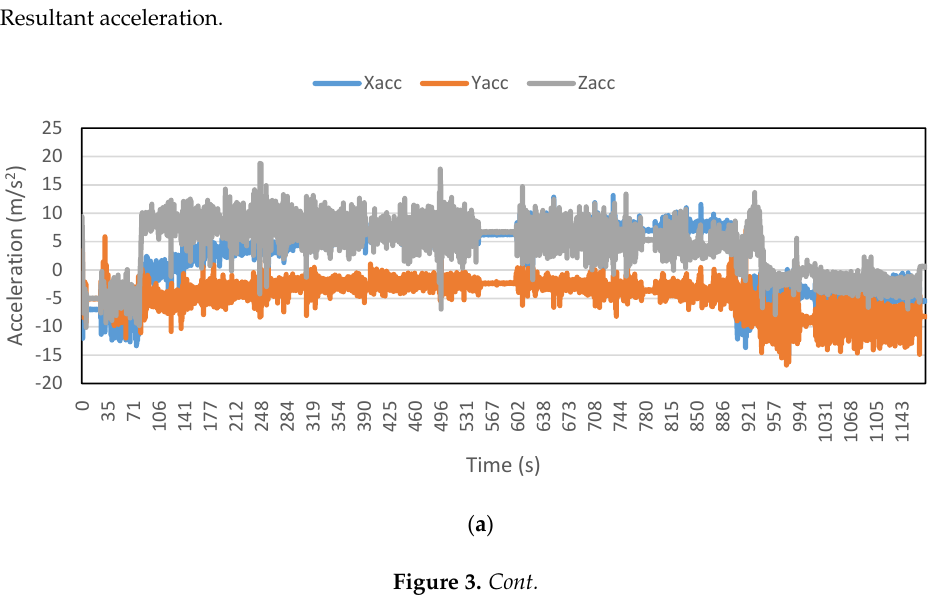
Figure 2. Accelerations recorded for a walk trip: ( a ) Accelerations along three axes; and ( b ) Resultant acceleration.